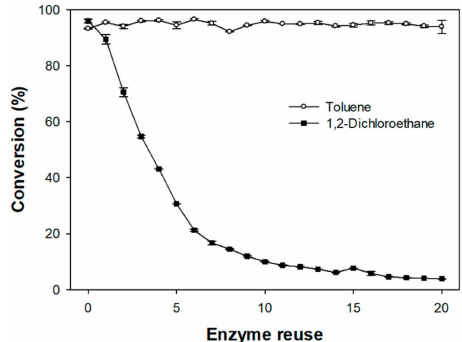
Figure 7. Recycling of Novozym 435 enzymatic activity in 1,2-dichloroethane and toluene. The conversion yield (%) was calculated by GC